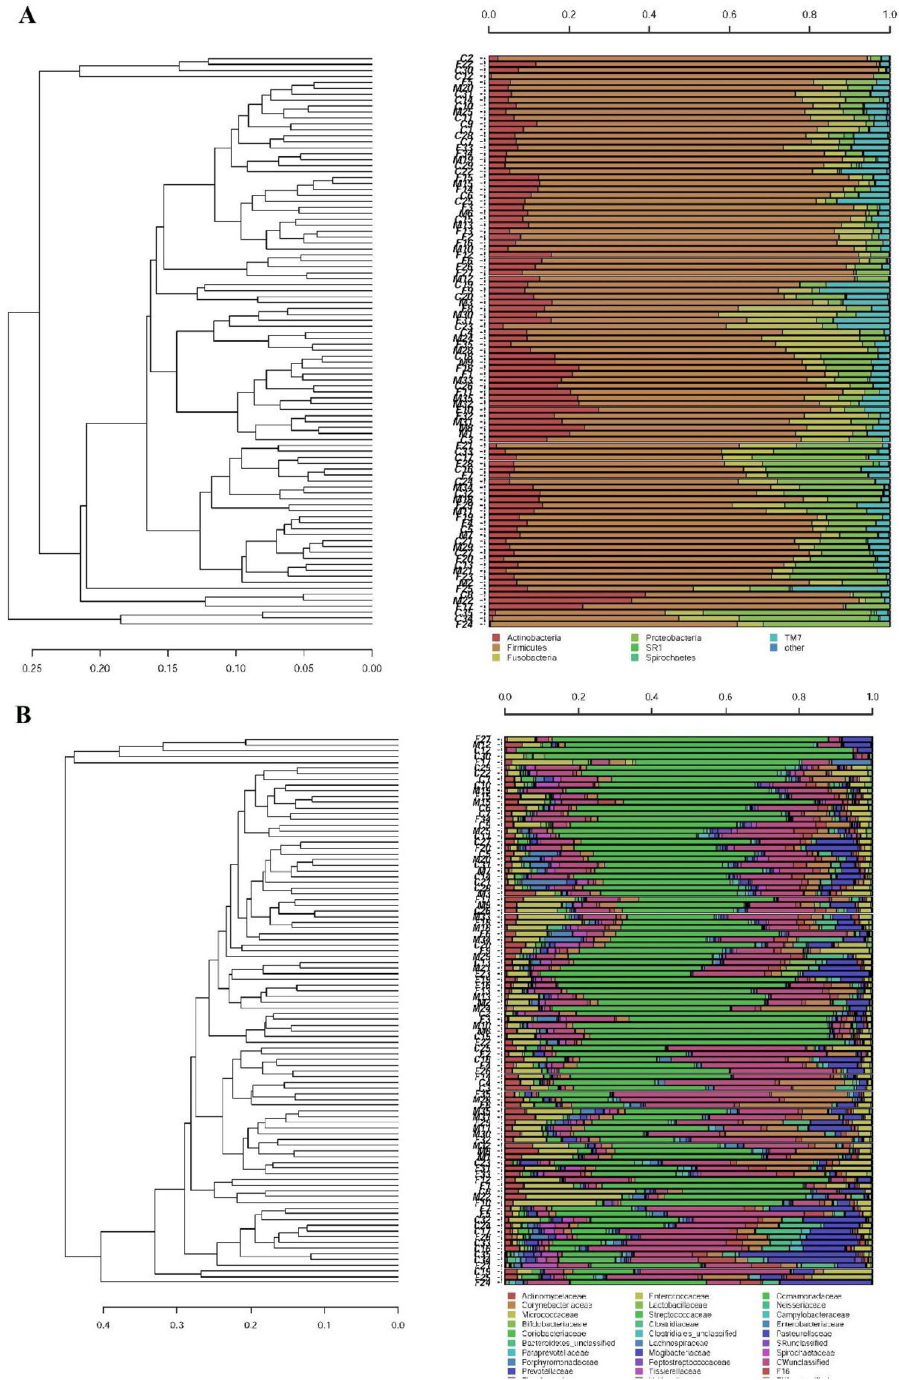
Figure 4. Hierarchical cluster analysis of classified sequences at phylum ( A ) and family ( B ) classification levels. The three experimental groups are indicated as M (CFS patients), F (patients’ relatives), and C (healthy controls). Bars of different colors indicate the relative percentage of bacterial phyla identified in each salivary sample. Only taxa ≥ 5% in at least one sample are shown. Similar samples were clustered using the average linkage